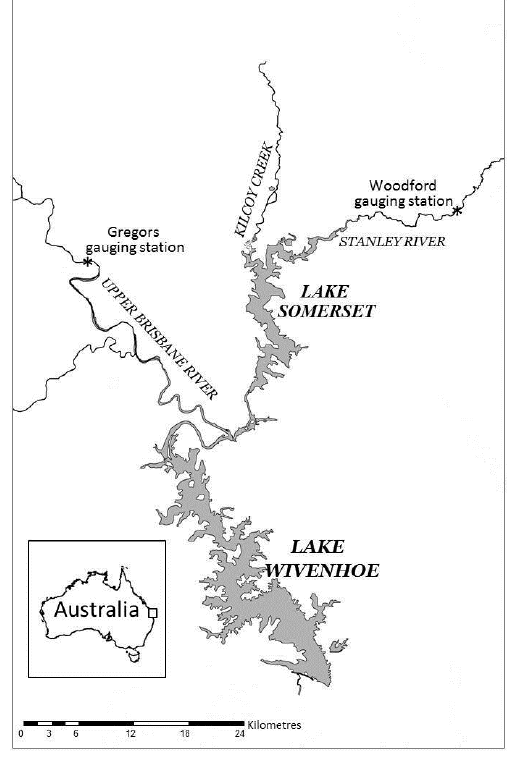
Figure 1. The Somerset and Wivenhoe reservoirs in subtropical Australia. The major tributaries are the Stanley River and Upper Brisbane River (UBR), respectively. Flow gauging stations are indi-